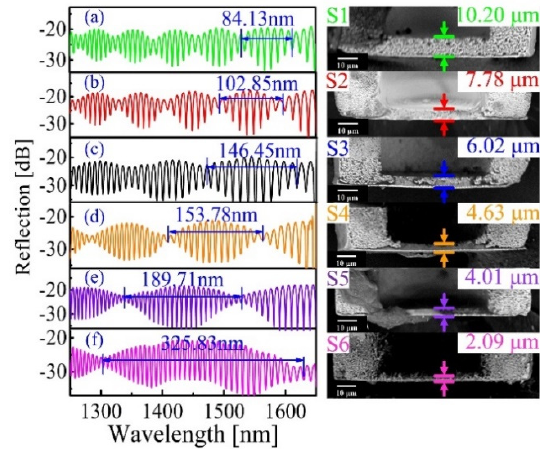
Figure 2. Reflection spectra (left column) and the corresponding SEM images (right column) of the six fabricated fiber tip FPI sensors with different diagram thickness. ( a ) S1 ( d = 10.20 μ m), ( b ) S2 ( d = 7.78 μ m), ( c ) S3 ( d = 6.02 μ m), ( d ) S4 ( d = 4.63 μ m), ( e ) S5 ( d = 4.01 μ m), and ( f ) S6 ( d = 2.09 μ m).